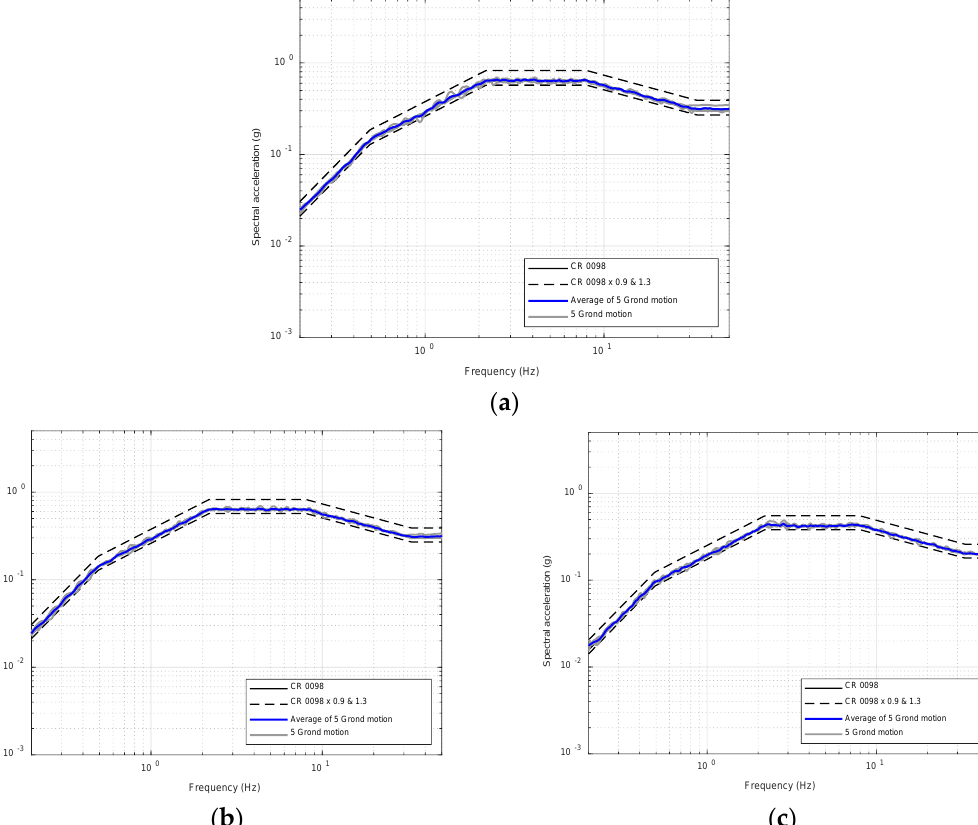
Figure 5. Target, mean, and individual response spectra of the matched ground motions: ( a ) H1; ( b ) H2; ( c ) V. Table 3. Ground motion records.